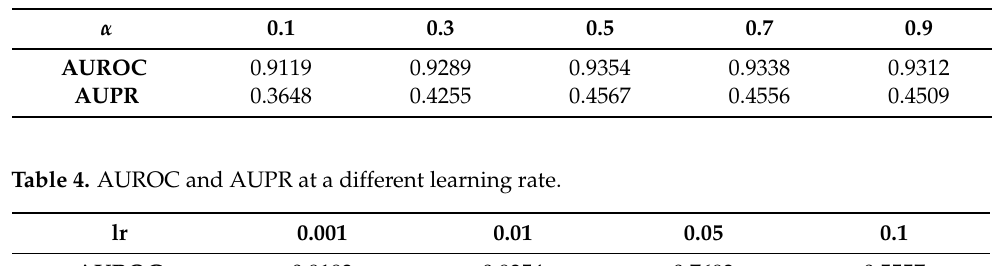
Table 3. AUROC and AUPR at different α .